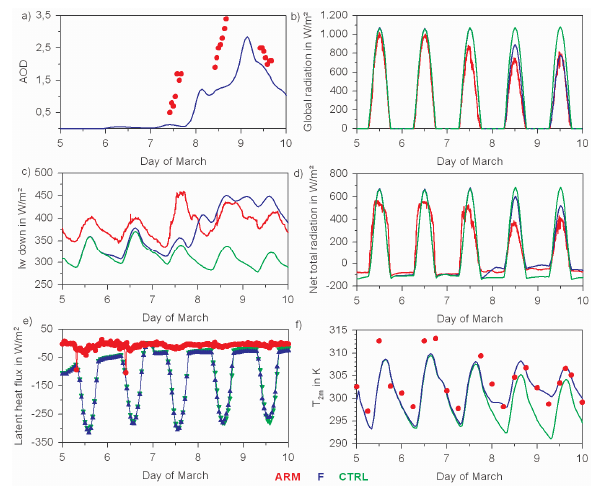
Figure 6: Simulated AOD at 450 nm and observed AOD at 415 nm (taken from Slingo et al. (2006), fig. 2), shortwave downward radiation, longwave downward radiation, net radiation, Fig. 6. Simulated AOD at 450nm and observed AOD at 415nm latent heat flux, and 2 m temperature during 5-10 March 2006 at Niamey. Observations: red, run F: blue, run CTRL: green. (taken from Slingo et al. (2006), Fig. 2), shortwave downward radi- ation, longwave downward radiation, net radiation, latent heat flux, and 2m temperature during 5–10 March 2006 at Niamey. Observa- tions: red, run F: blue, run CTRL: